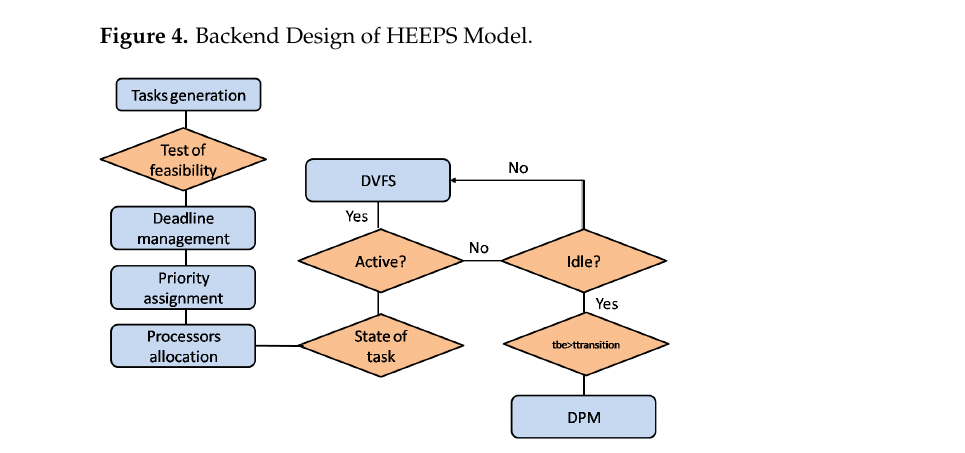
Figure 5. Flowchart of Execution of